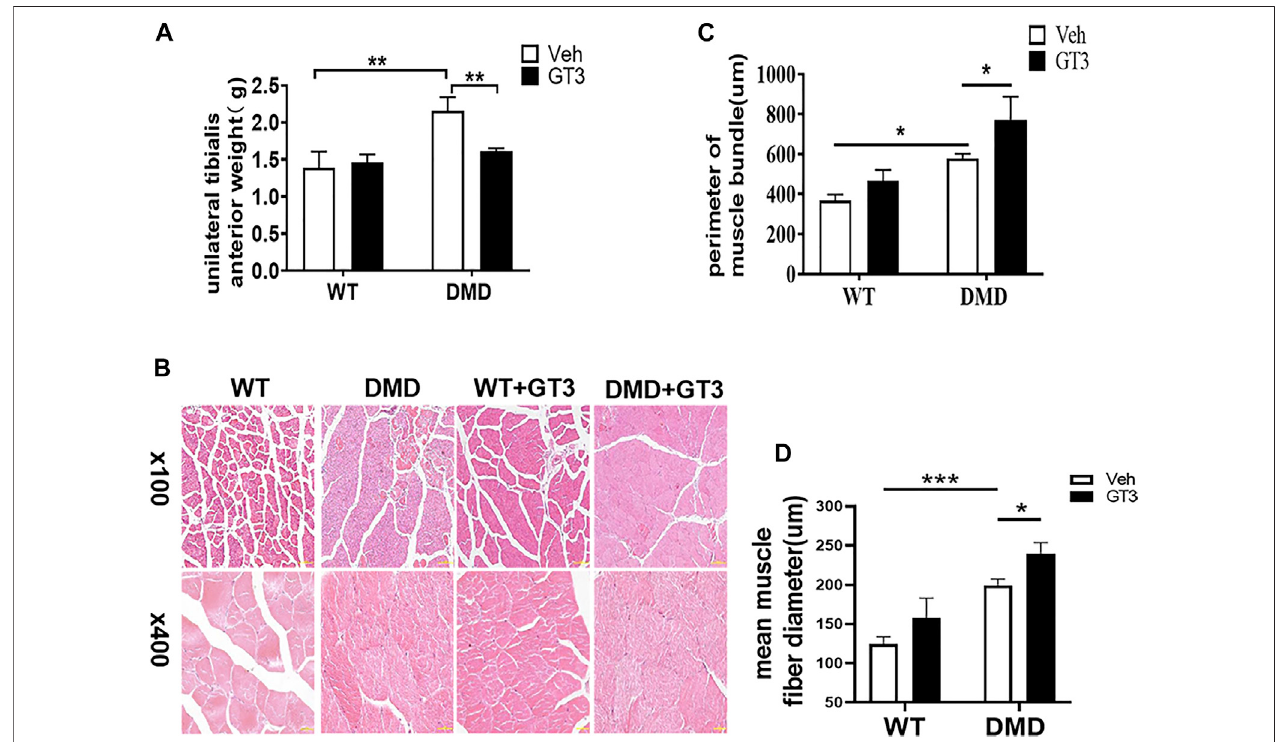
FIGURE 5 | Morphological changes of tibialis anterior in mice treated with GT3. (A) The mean wet weight of the left anterior tibial muscle of DMD mice before and after GT3treatment wascompared. Datawere presented at means ± SEM( n =6) with two-way ANOVA analysis.** p < 0.01. (B) HE staining oftibialis anteriormuscle of miceindifferenttreatment groups. (C) Comparison ofthegirthoftibialisanteriormuscleinmiceofdifferenttreatment groups.Datawerepresented atmeans±SEM( n = 6) with two-way ANOVA analysis. * p < 0.05. (D) Quanti fi cation and comparison in the mean diameter of the ferret for myo fi ber. Data were presented at means ± SEM ( n = 6) with two-way ANOVA analysis. * p < 0.05, *** p < 0.001.